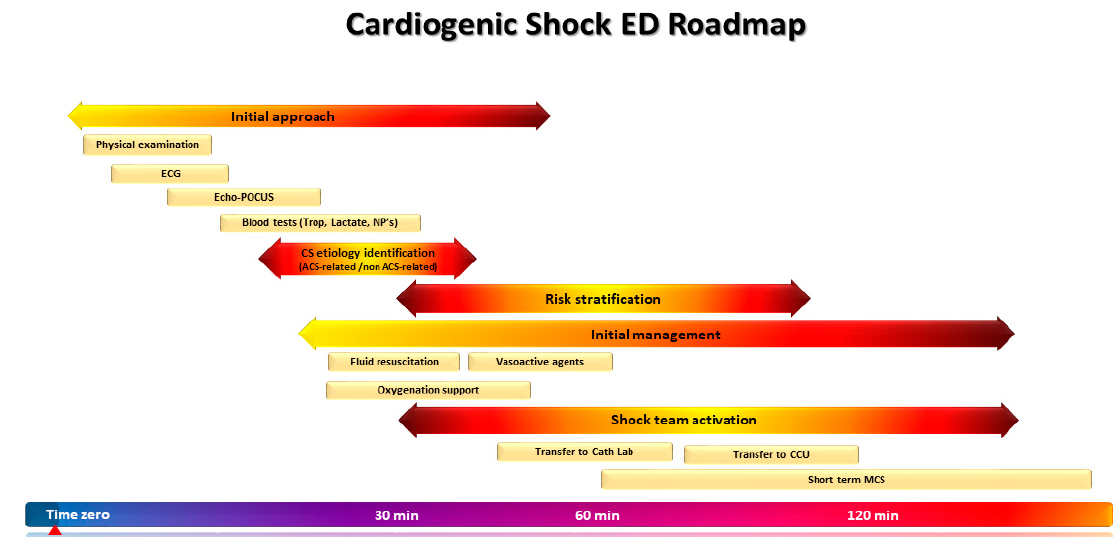
Figure 1. The roadmap of the patients presenting in the emergency department (ED) with cardio- genic shock (CS). A timely and structured approach upon presentation to the ED ensures prompt identification of CS, its underlying etiology, and risk stratification, in order to guide decision making and patient disposition without delay.